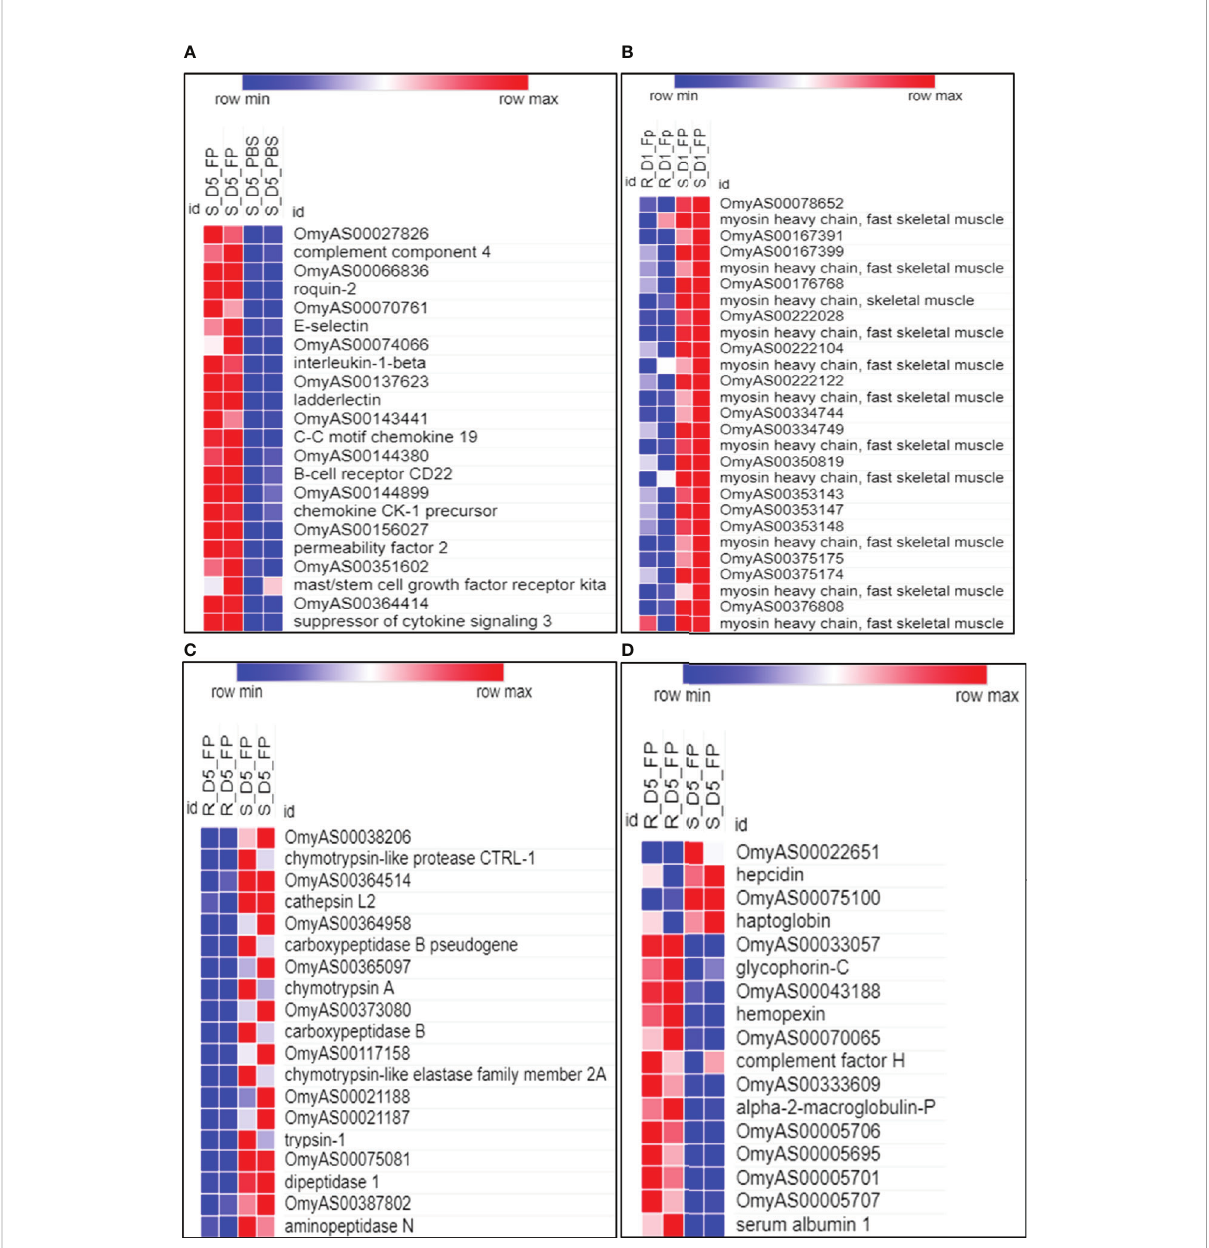
FIGURE 6 Comparison of transcriptome abundance of selected DE lncNATs and their sense genes. (A) Unique DE lncNATs, complementary to immune- related genes, in susceptible fi sh on day 5 post-infection. (B – D) DE lncNATs between resistant and susceptible genetic lines overlap with genes related to muscle contraction (B) , proteolysis (C) , and iron homeostasis (D) . Normalized expression from sense genes is visualized on the heatmap below the corresponding lncNAT(s). D1 and D5 indicate day 1 and day 5 post-challenge, respectively. FP and PBS indicate Fp and PBS injection, respectively. R and S represent resistant and susceptible genetic lines of the fi